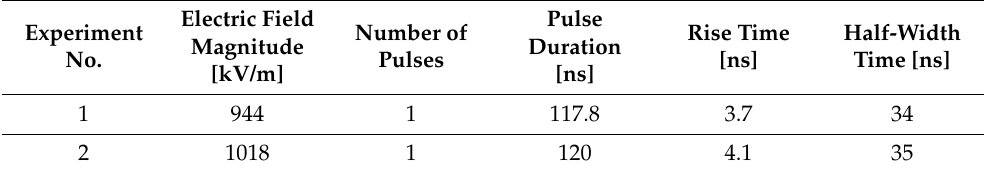
Table 1. Parameters of the electromagnetic pulse: electric field magnitude, number of pulses, pulse duration, rise time, and half-width